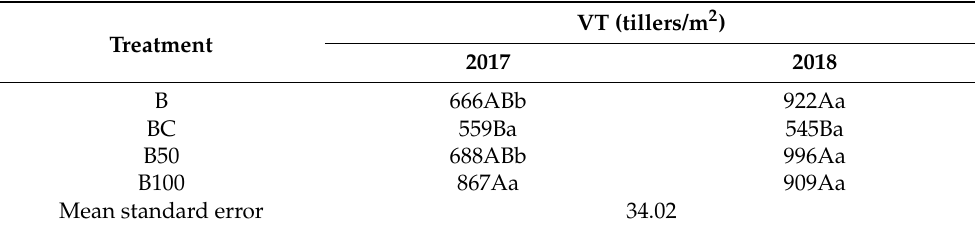
Table 5. Averages of the number of vegetative tillers (VTs) for different treatments and experimental years at the end of the deferral